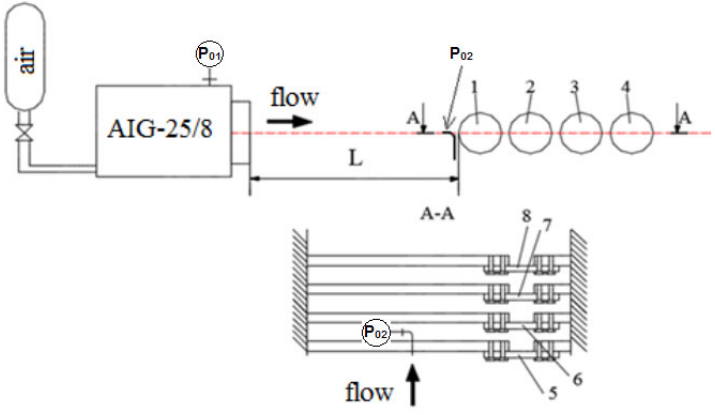
Figure 3. Experimental test bench.